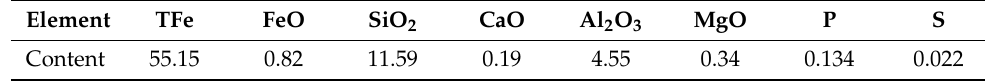
Table 2. Chemical composition of iron ore powder (wt%).